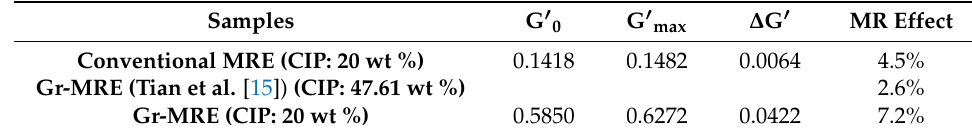
Table 3. The MR effect on the storage modulus of the MRE samples.